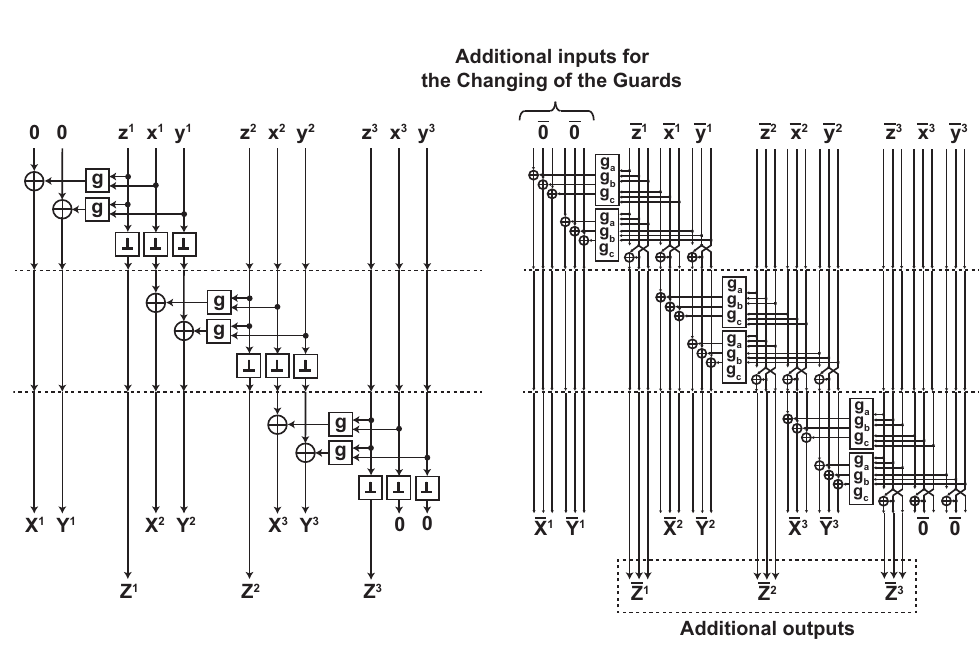
Figure 6: Cascaded h R (left) and its sharing